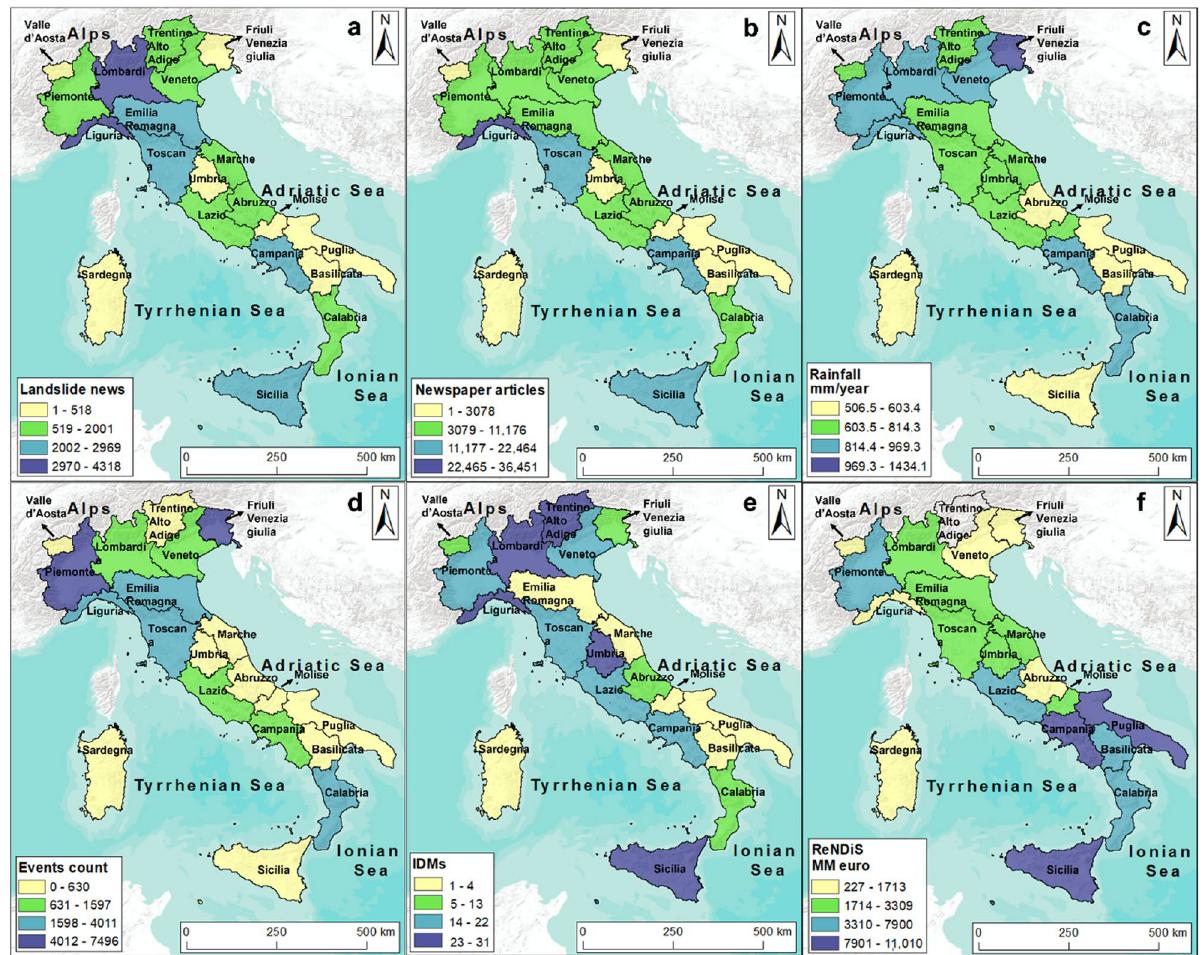
Figure 5. ( a ) Regional aggregation with “landslide news”, estimating landslide hazard; ( b ) regional aggregation with media impact, estimating landslide intensity; ( c ) regional distribution with rainfall data for 10 years (mm/10 years); ( d ) regional aggregation of relevant rainfall event counts (events display relevant differences in spatial distribution); ( e ) regional aggregation with IDMs from the Polaris dataset (the period covers only 9 years, from 2011 to 2019); ( f ) regional aggregation with earmarked funds for soil protection from ReNDiS (euro/10 years) for 10 years, considering landslide events. The map was generated using ESRI ArcMap 10.8.1 (https:// www. arcgis. com/ home/ item. html? id= 33064 a20de 0c48d 2bb61 efa8f aca93